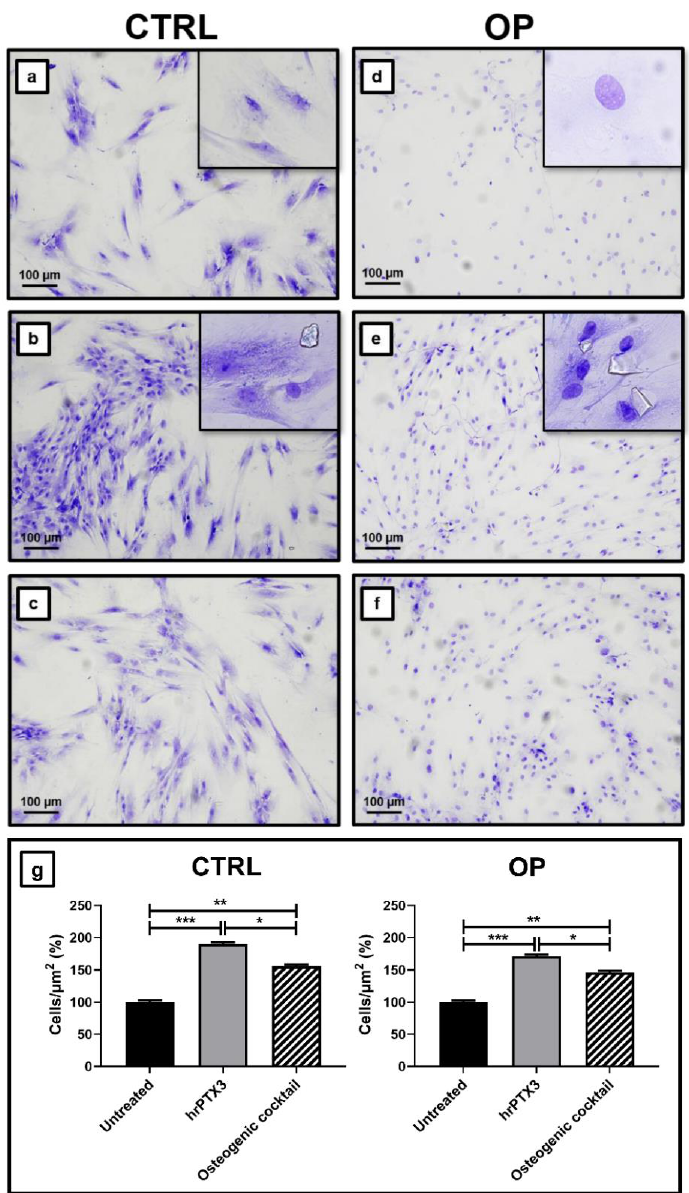
Figure 3. Effects of hrPTX3 and osteogenic cocktail treatment on primary osteoblasts cultures. The effects of hrPTX3 and osteogenic cocktail treatment on cell differentiation and proliferation were assessed by Toluidine blue staining. ( a ) Untreated osteoblasts isolated from CTRL patients showed the classic phenotype of a mature osteoblast. ( b ) Treatment with hrPTX3 induced the formation of cell clusters and calcification-like structures. ( c ) The inductive effect on proliferation and clustering was also evident following treatment with osteogenic cocktail. ( d ) Untreated osteoblasts isolated from OP patients showed a fibroblast-like phenotype. ( e ) Treatment with hrPTX3 promoted dif- ferentiation towards the osteoblastic lineage and formation of numerous calcification-like struc- tures. ( f ) The osteogenic cocktail also had an inductive effect on proliferation. ( g ) Graphs show the effect of treatments on proliferation in both CTRL and OP patient cultures. 10x images, scale bar represents 100 μm. In the two experimental groups, the increase in proliferation seems to accompany the acquisition by both CTRL and OP osteoblasts of the ability to organize into cell clus-